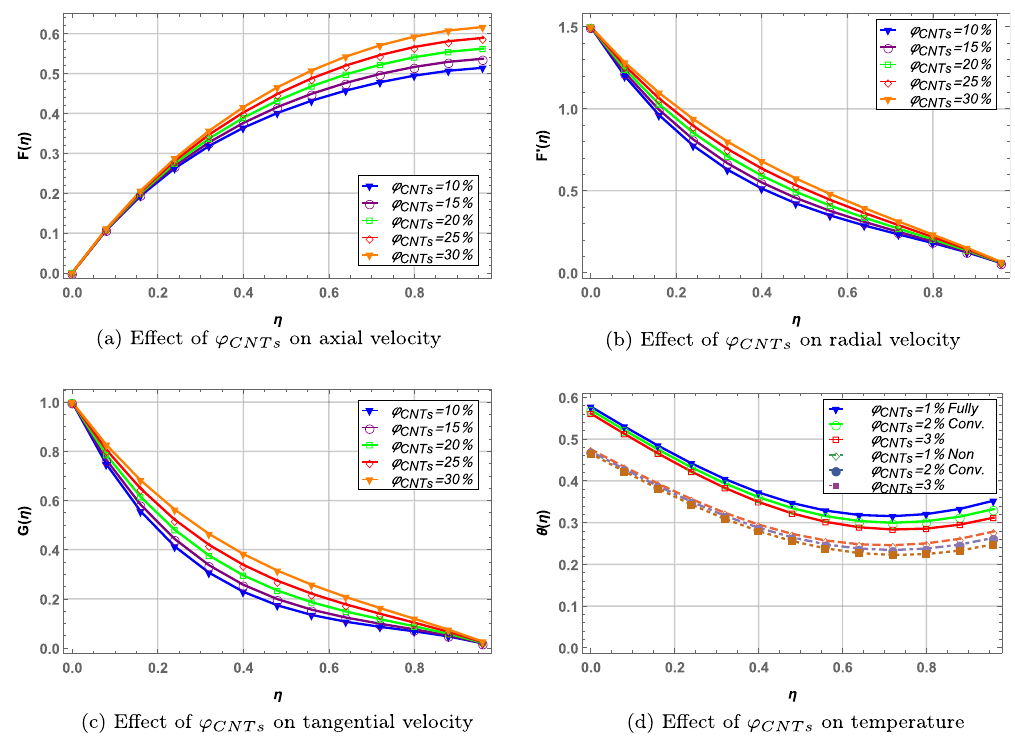
Figure 8. Effect of MWCNTs volume fraction on velocity and temperature profile when ϕ UO 2 = 2% .